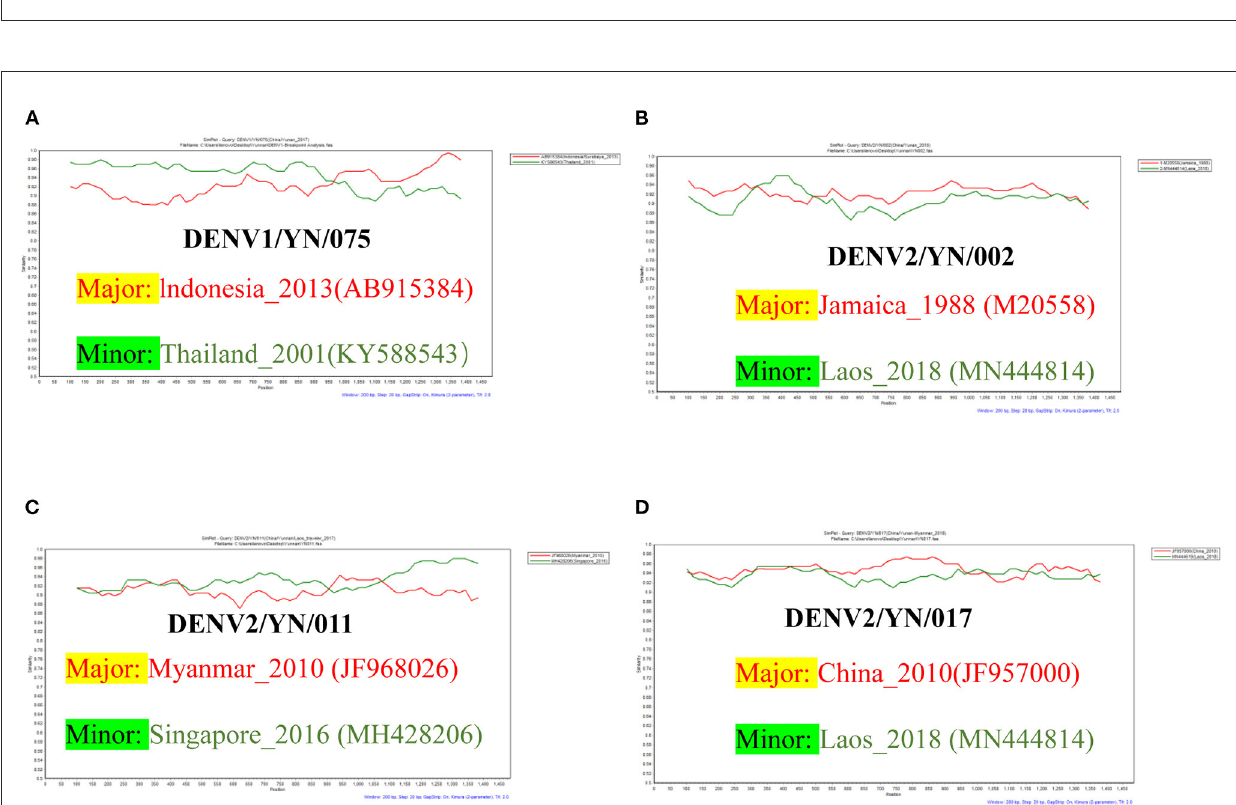
FIGURE6 (A) Recombination analyses of the YN/075 isolate, which is composed of the parental strain (Indonesia/Surabaya, AB915384) and the minor strain (Thailand, KY586543). (B) Recombination analyses of the YN/002 isolate, which is composed of the parental strain (Jamaica, M20558) and the minor strain (Laos, MN444614). (C) Recombination analyses of the YN/011 isolate, which is composed of the parental strain (Myanmar, JF968026) and the minor strain (Singapore, MH428206). (D) Recombination analyses of the YN/017 isolate, which is composed of the parental strain (China, JF957000) and the minor strain (Laos,